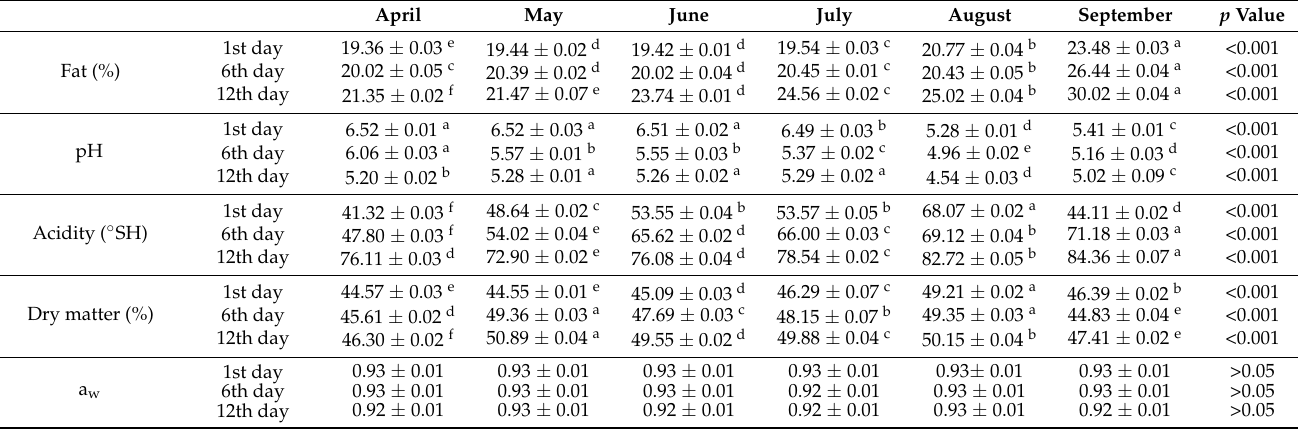
Table 4. Means and their standard deviations (mean ± SD) of the physical and chemical indicators of sheep cheese samples at 1st, 6th, and 12th day of